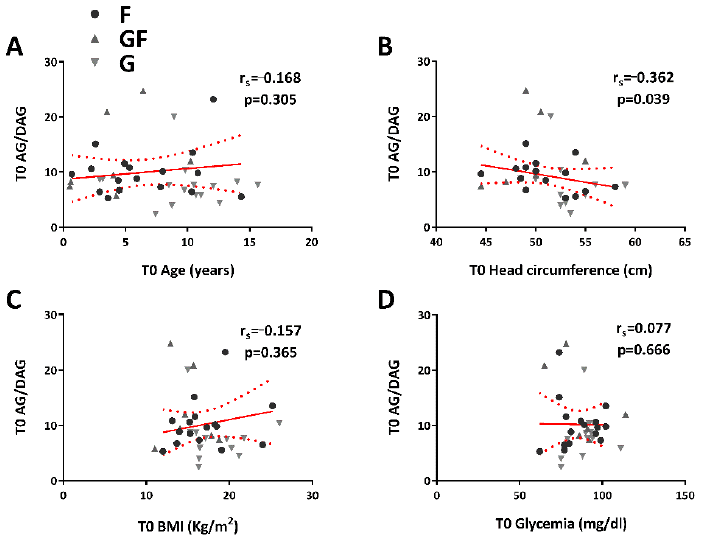
Figure 5. Relationship between ghrelin (AG)-to-des-acyl ghrelin (DAG) ratio and age, head circumference, body mass index (BMI), and glycemia ( A – D ). Spearman correlation coefficients are